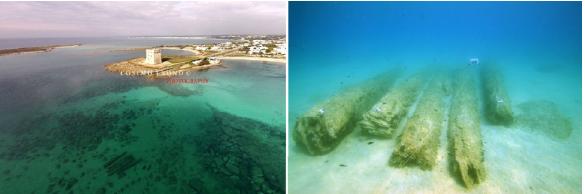
Figure 4. The five columns of the archaeological site. (On